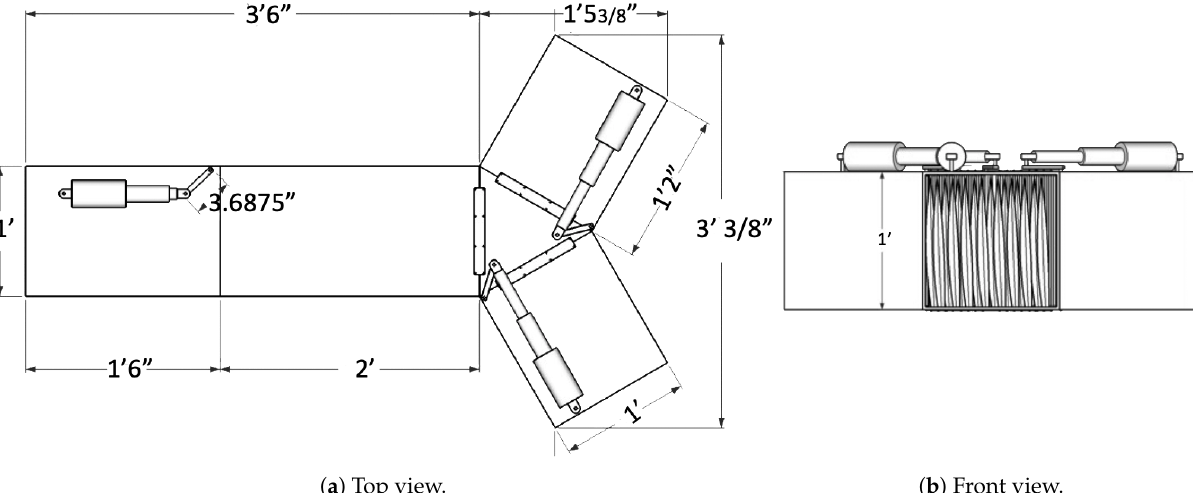
Figure 4. The design and dimensions of the four-chamber fish separation mechanism.